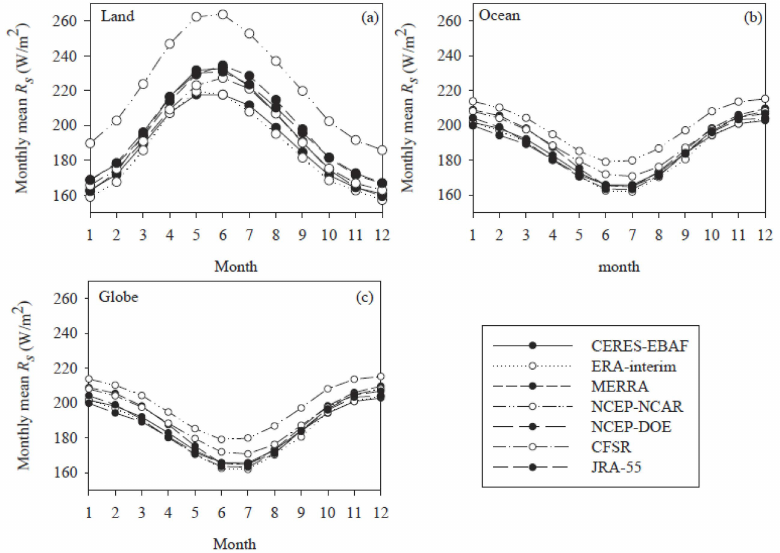
Figure 9. Seasonal variability in R s calculated from the global reanalyses and CERES-EBAF R s data from 2001 to 2009: ( a ) land; ( b ) oceans; ( c ) the